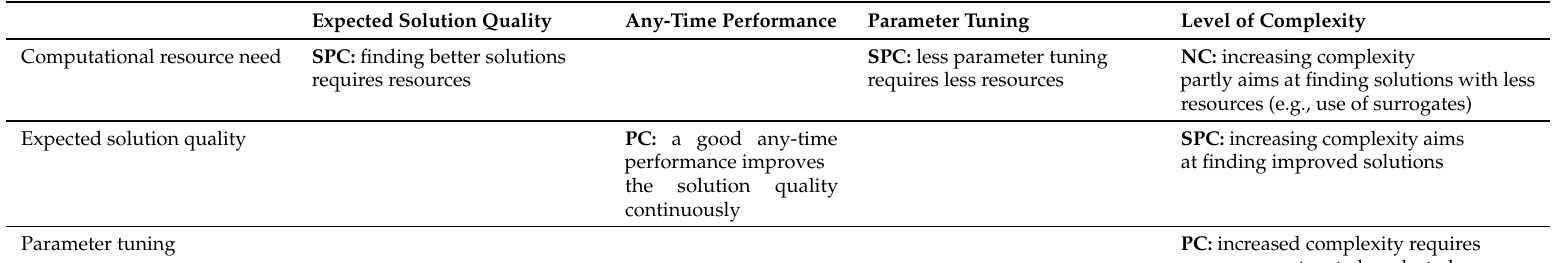
Table A1. Correlations between the quality criteria for the Decision Matrix. The correlations are: SPC , strong positive correlation; PC , positive correlation; NC , negative correlation; SNC , strong negative